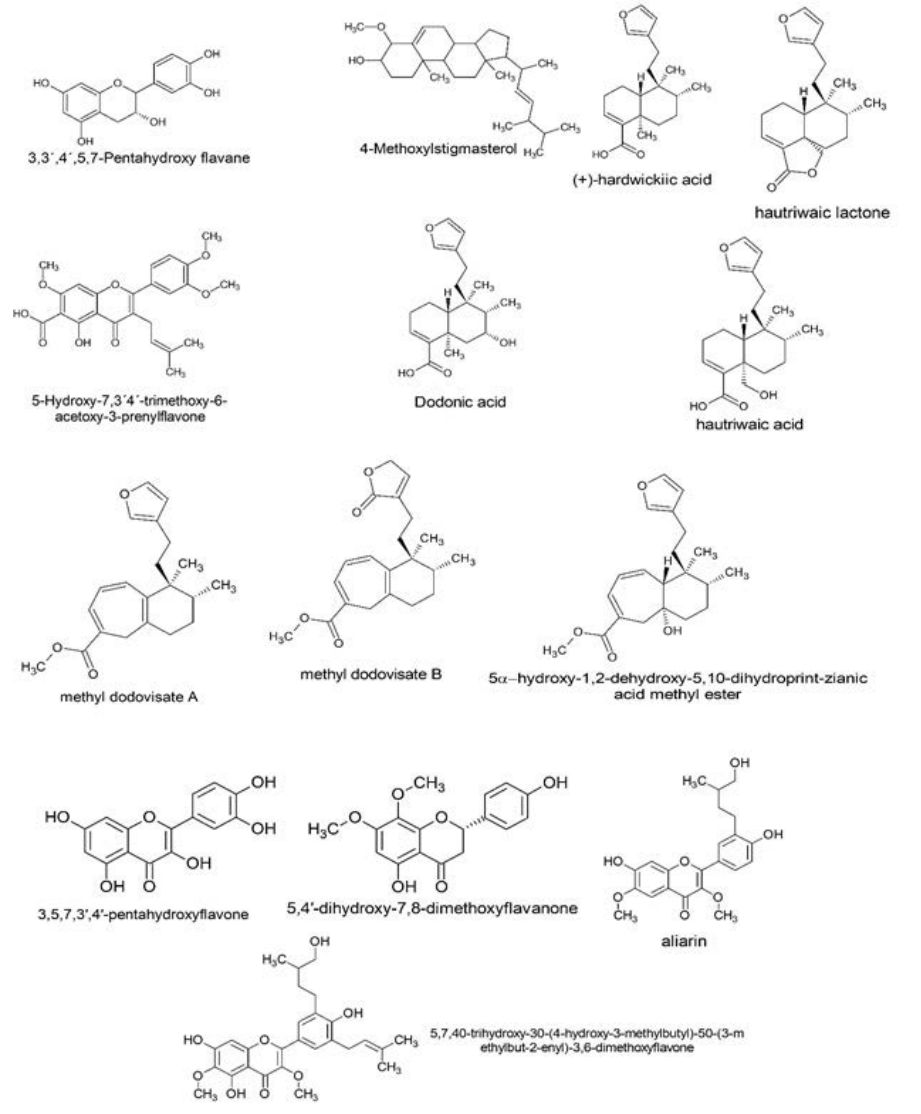
Fig. 2a. Chemical constituents reported in Dodonaea viscosa Jacq